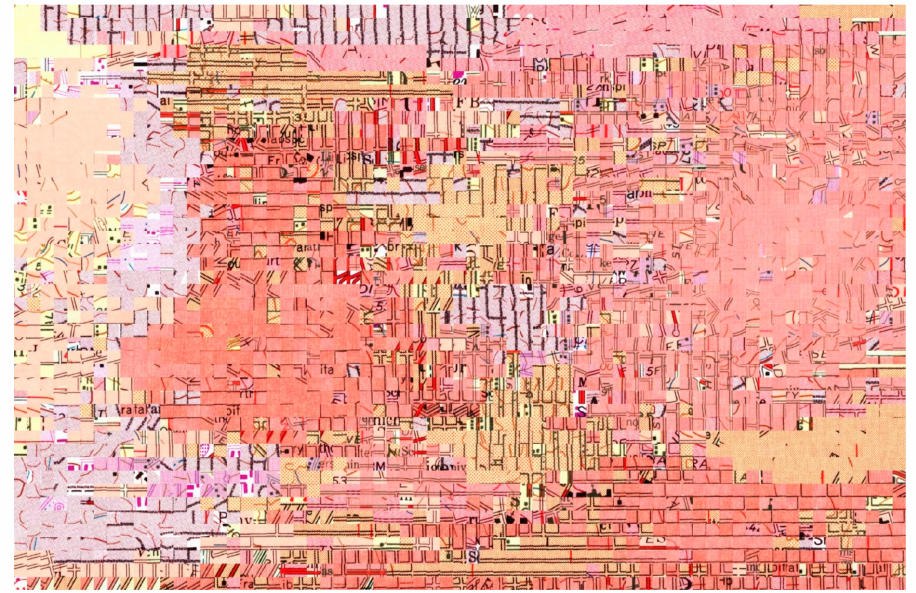
Figure 15. T-SNE arrangement of cross-map samples of patches likely to contain dense urban settlement